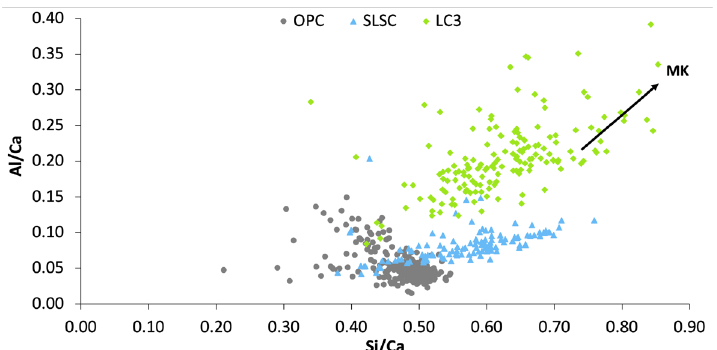
Figure 9. Comparison of Al/Ca and Si/Ca ratios in C-A-S-H gel at the age of 90 days for OPC, LC 3 and